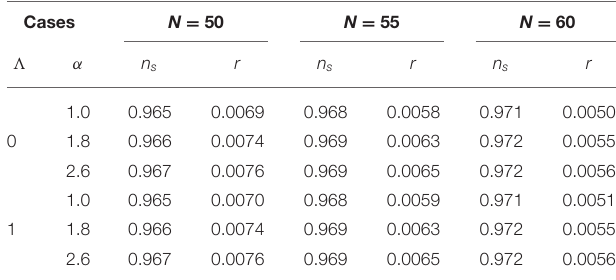
TABLE 1 | Values of the spectral index n s and tensor-to-scalar ratio r obtained from the RG-improved model (62) for different values of ( α , 3 ) and number of e-folds N [